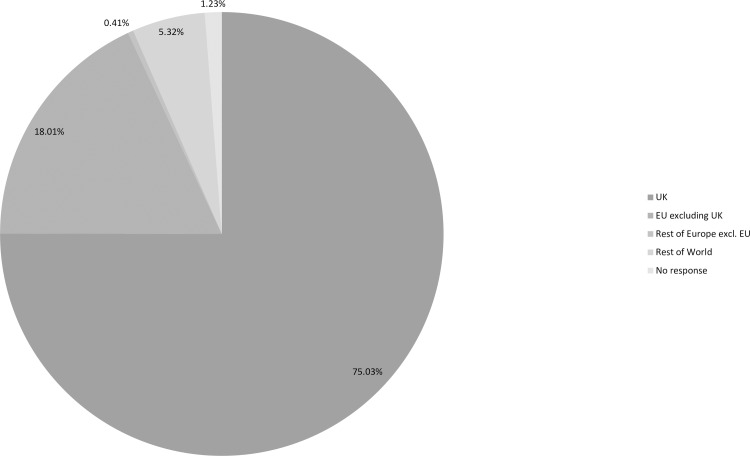
Residence profile of participants (S3 Table).